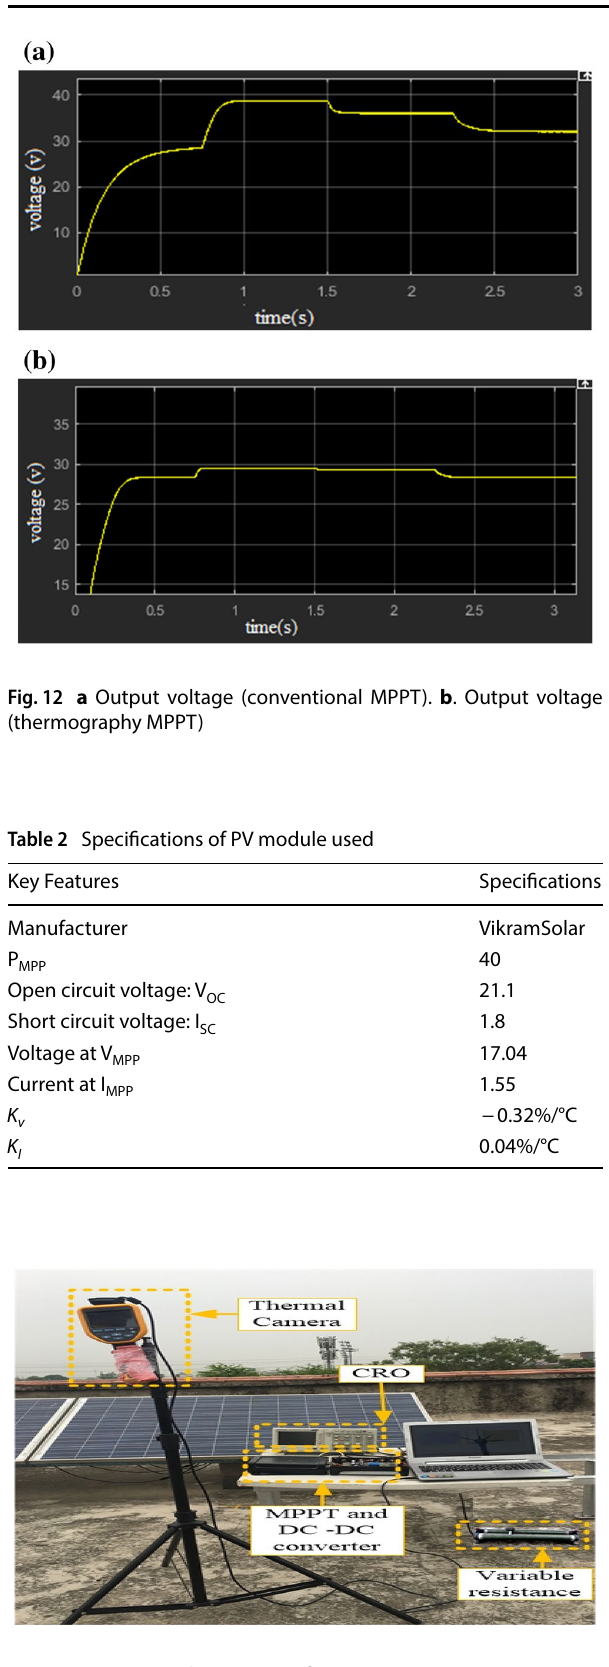
Fig. 13 Experimental setup at rooftop